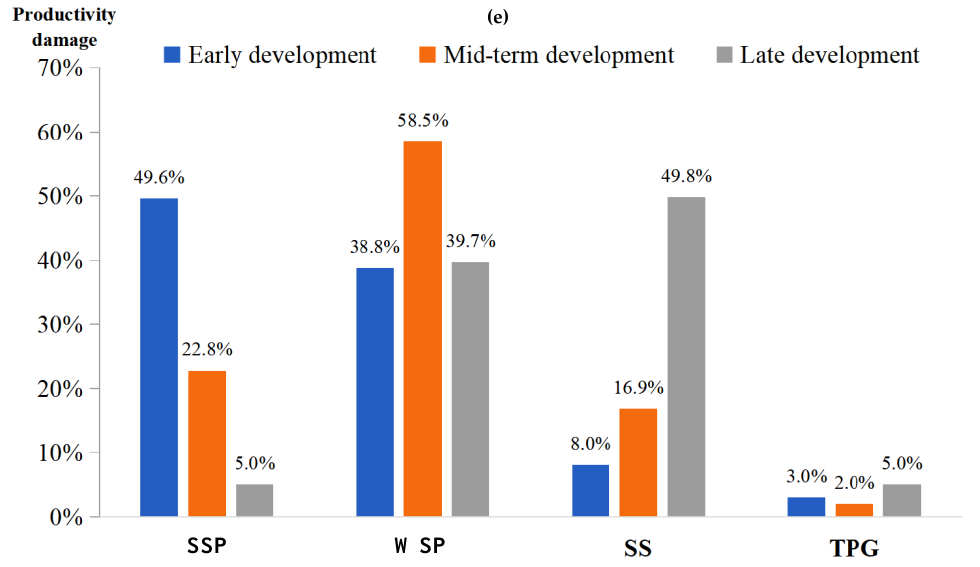
Figure 14. The influence of each pollution factor on the production in the whole development cycle. ( a ) The influence of solid solute pollution. ( b ) The influence of water solvent. ( c ) The influence of stress sensitivity. ( d ) The influence of threshold pressure gradient. ( e ) The contribution of each pollution factor.